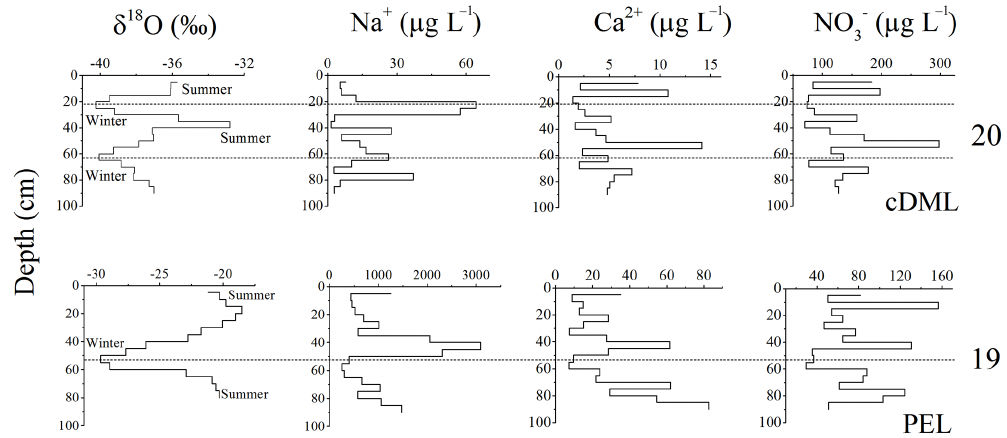
Figure 2. Oxygen isotope ratios and major ions showing seasonality in representative snow cores from inland (cDML, core 20) and coast (PEL, core 19). The dotted lines represent winter maxima in the cores.